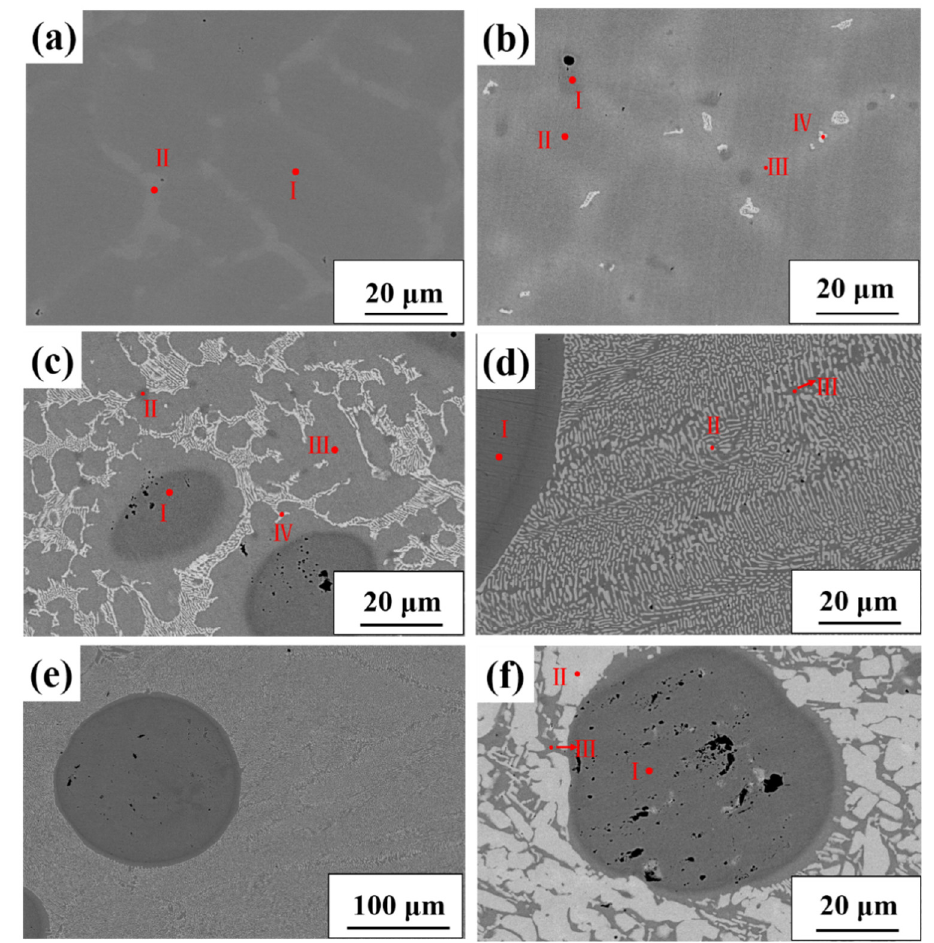
Figure 2. Backscattered electron (BSE) images of (CoCuFeNi) 100- x Mo x HEAs: ( a ) x = 0, ( b ) x = 10, ( c ) x = 15, ( d , e ) x = 19, ( f ) x = 25.